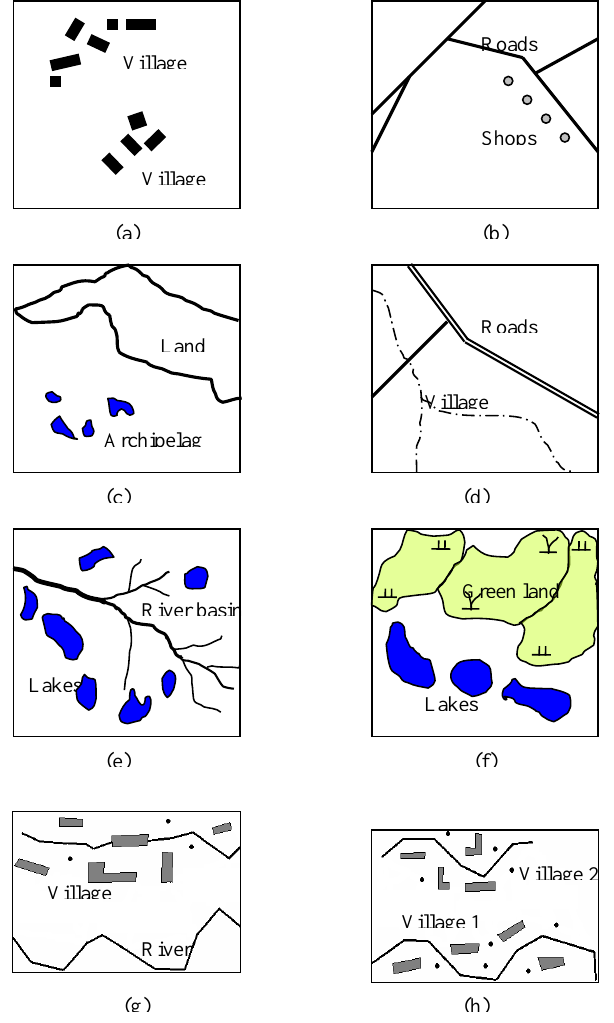
Fig.2 Examples of various pairs of object groups: (a) Fig. 2. Examples of various pairs of object groups: (a) points– points-points; (b) points-lines; (c) points-polygons; (d) points; (b) points–lines; (c) points–polygons; (d) lines–lines; (e) lines-lines; (e) lines-polygons; (f) polygons-polygons; (g) lines–polygons; (f) polygons–polygons; (g) line–complex; and (h) line-complex; and (h) complex-complex. complex–complex.